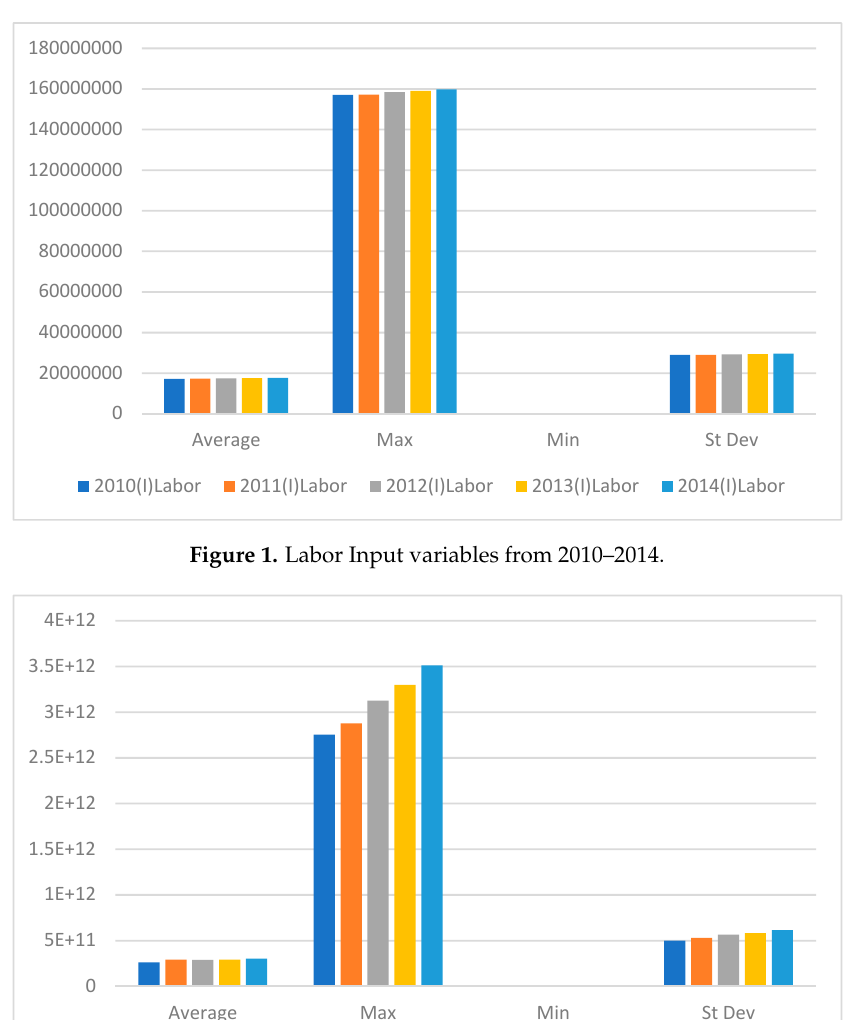
Int. J. Environ. Res. Public Health 2019 , 16 , x Figure 2. Fixed asset Input variables from 2010–2014. Figure 2. Fixed asset Input variables from 2010–2014.